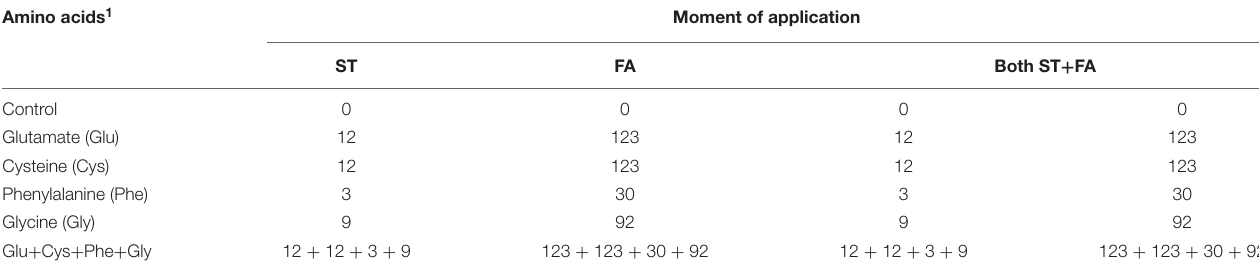
TABLE 1 | Treatments with different amino acids applied only on seed (ST), mg kg − 1 (seeds), foliar application (FA) at V 4 (mg ha − 1 ) only, and both ST + FA. Amino acids 1 Moment of